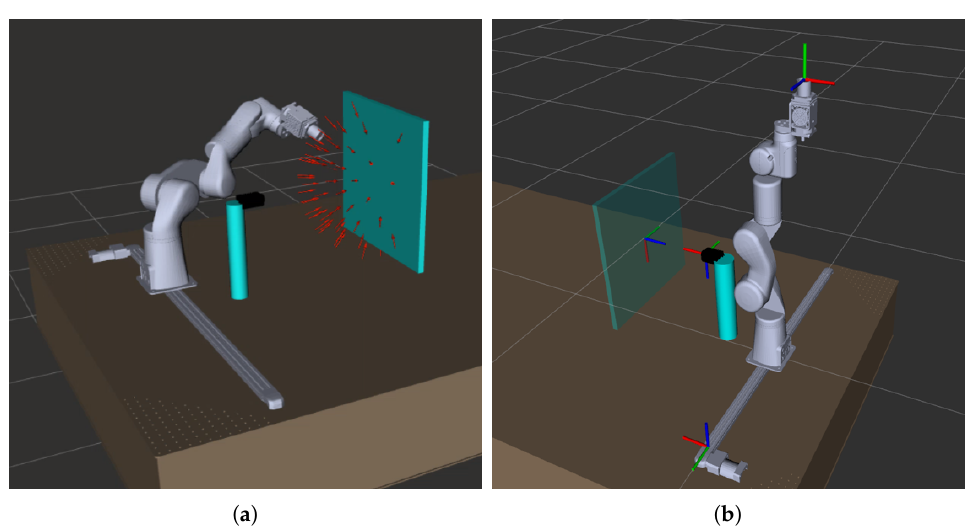
Figure 4. Visualization of the system in ROS RViz. ( a ) Visualization of the system and an example set of light poses in Rviz. ( b ) Reference frames to which the system components are